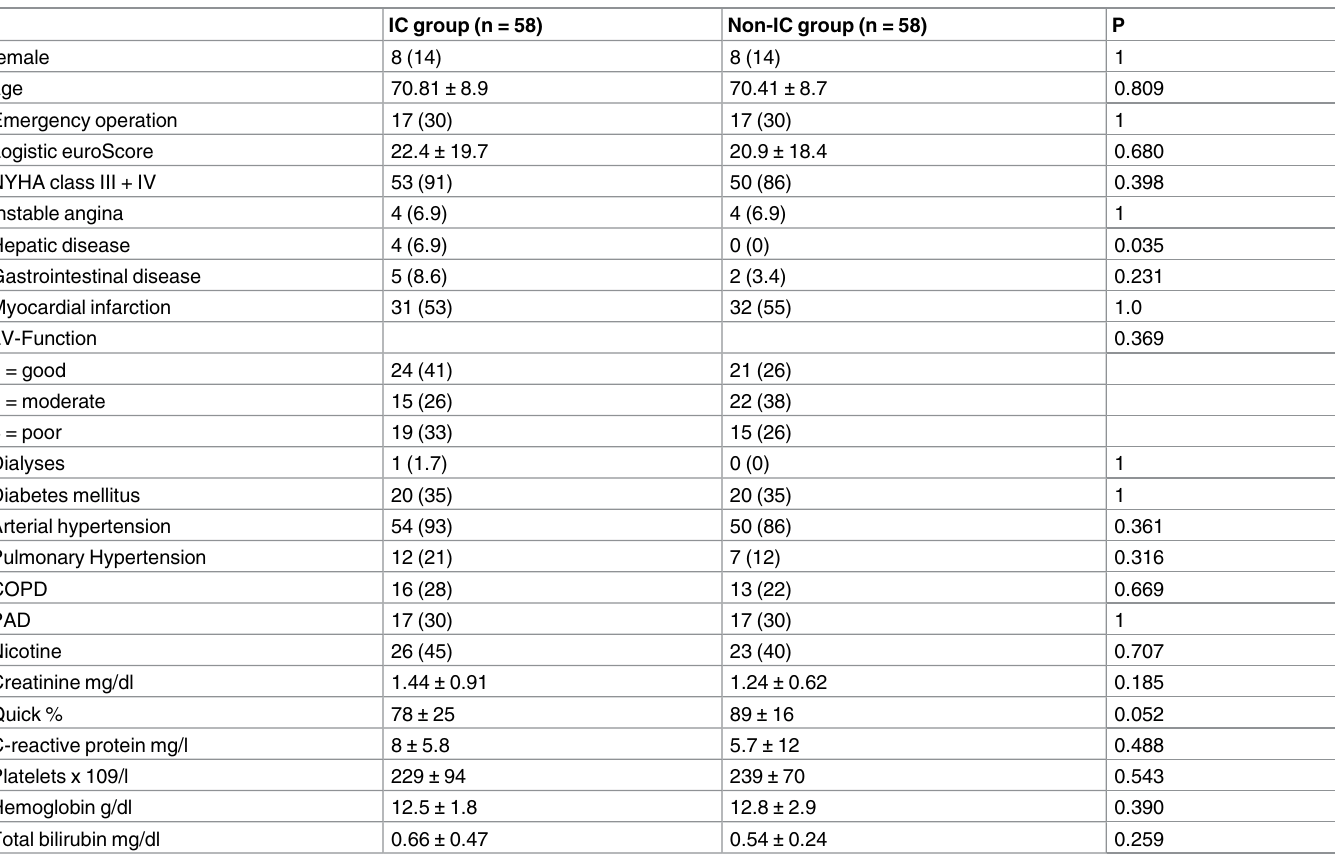
Table 1. PreoperativeData.